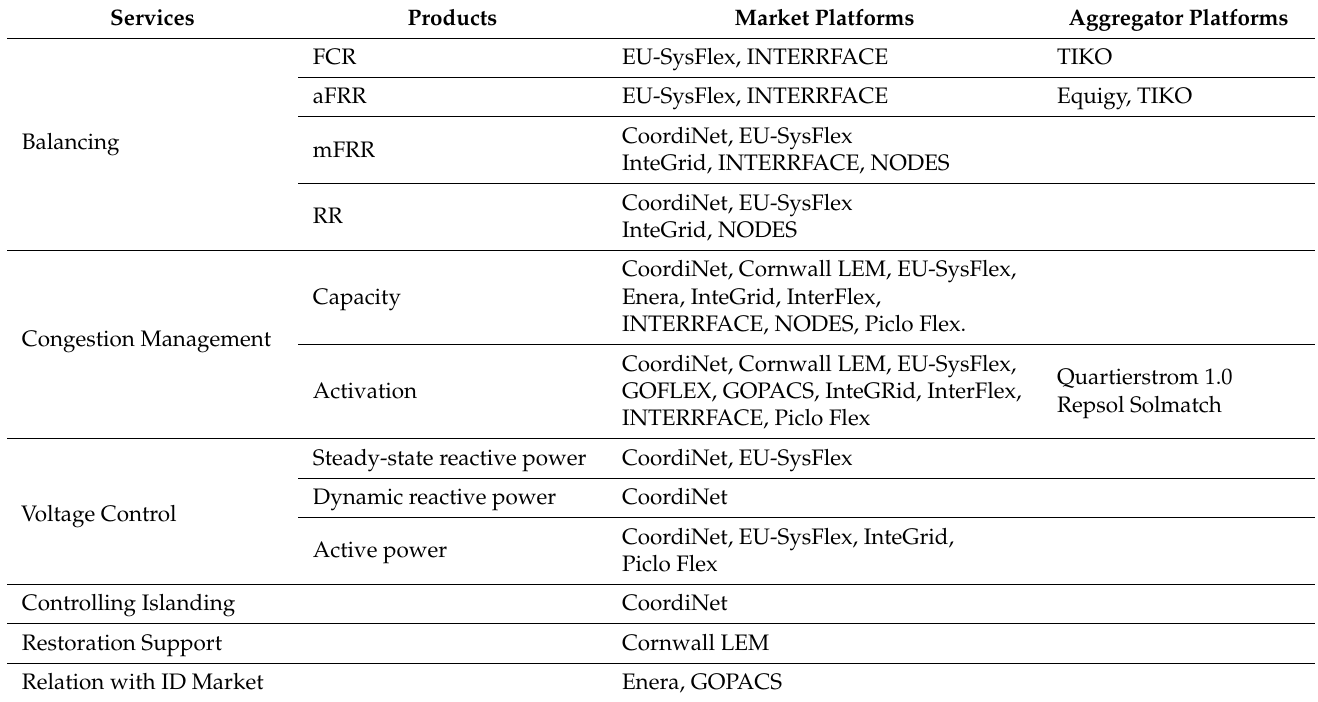
Table 3. Services and products in the new flexibility market